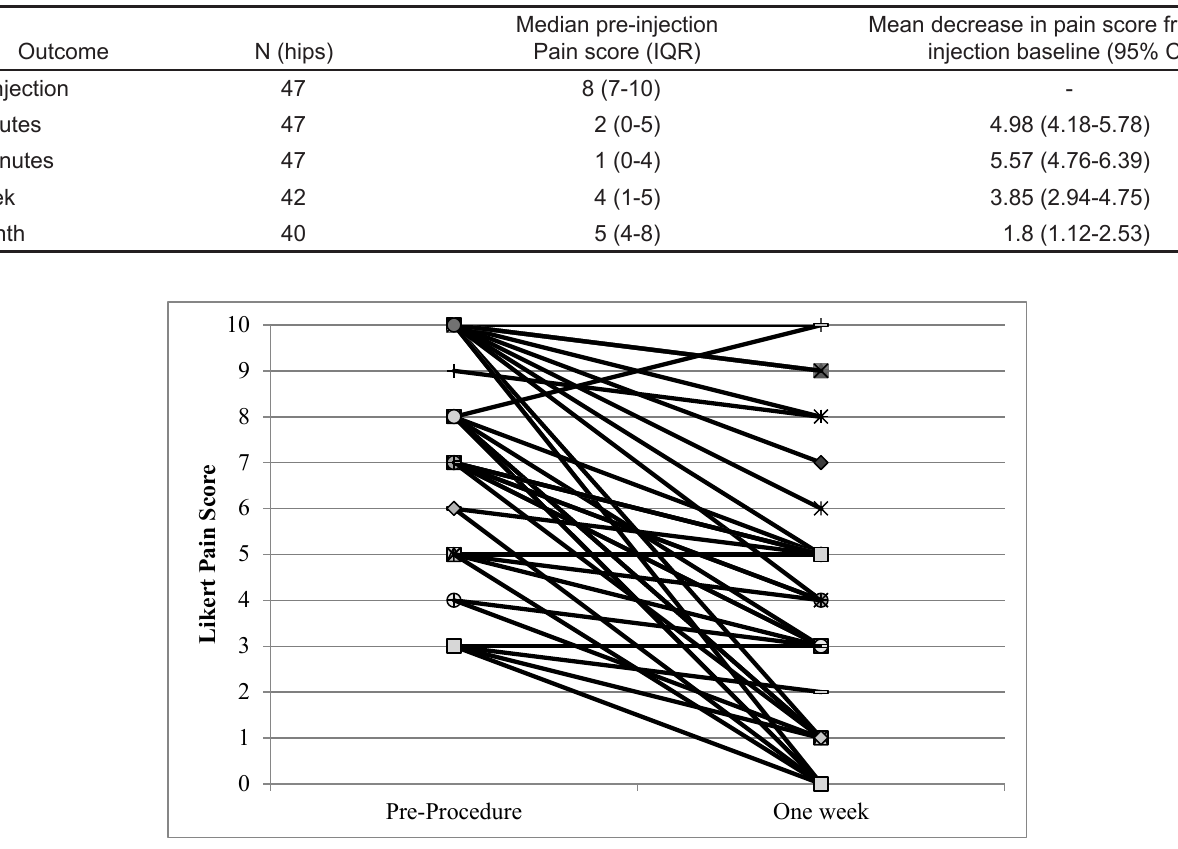
Figure 3. Individual patient pain scores from pre - injection to one week after hip injection.** **Includes 42/47 injections available for follow up at one week.